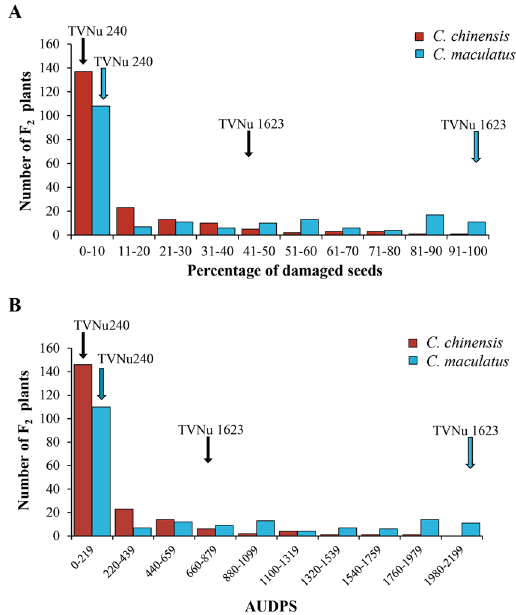
Figure 3. Frequency distributions of the percentage of damaged seeds ( A ) and the area under the disease progress strairs (AUDPS) ( B ) resulting from C . chinensis and C . maculatus infestation in the Vigna vexillata F 2 population of a cross between ‘TVNu 240’ and